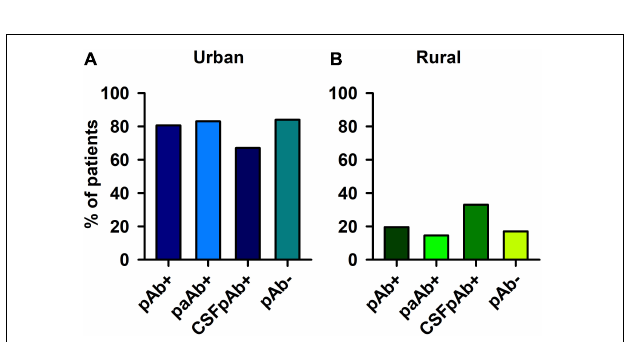
FIGURE 2 | Psychiatric patients with and without neural autoantibodies in urban and rural environment. Psychiatric patients presenting neural autoantibodies (pAb+), psychiatric patients with neural autoantibodies of a probable or definitive autoimmune origin (paAb+) and psychiatric patients with CSF neural autoantibodies (CSFpAb +) did not differ each from psychiatric patients without neural autoantibodies (pAb-) in an (A) urban and (B) rural